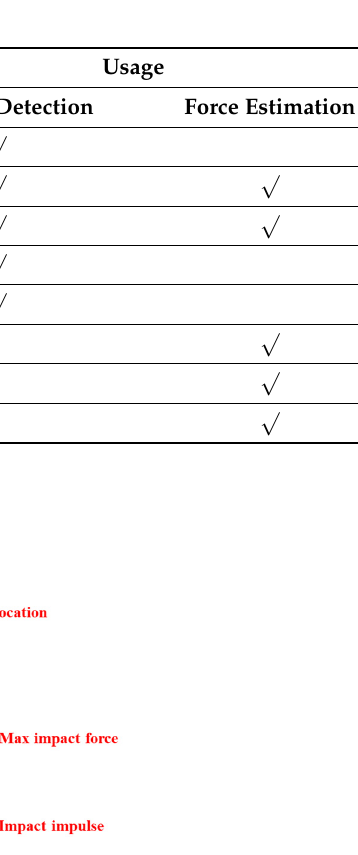
Table 1. Features extracted for impact force estimation.